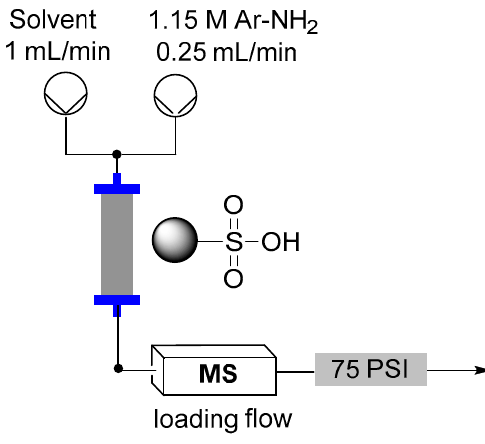
Figure 8. Flow reactor loading set-up. Table 2. Loading results for the supported acids using PhNH 2 in